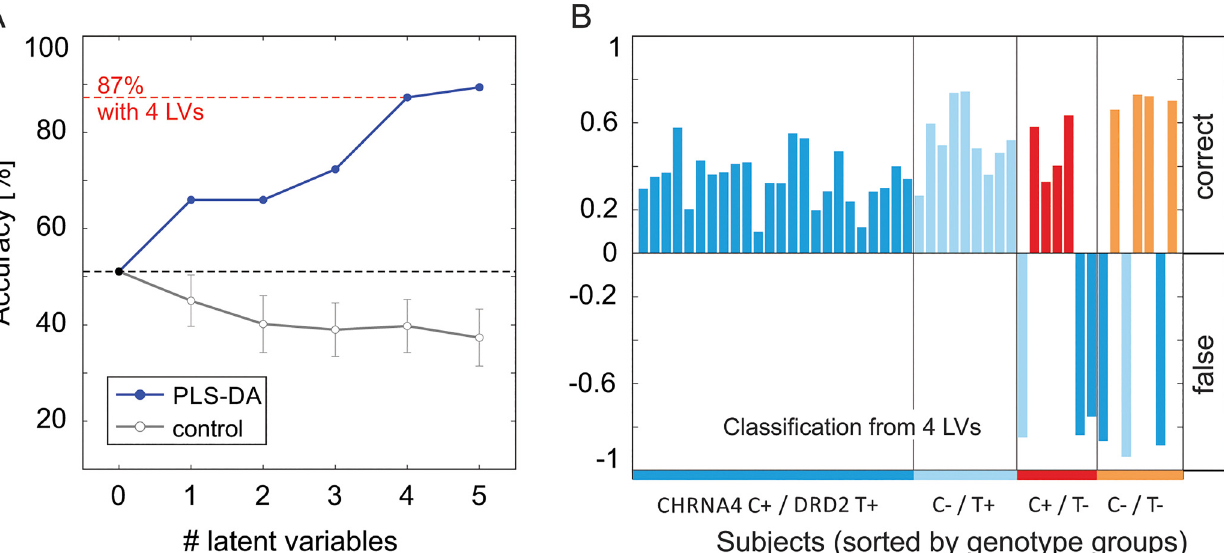
Fig 4. A. Classification accuracy. Prediction accuracy successively increases with adding LVs (blue). With four LVs, 41 out of 47 subjects (87.23%) were successfully assigned to their genetic group. When using no LV, all subjects were assigned to the genetic group with the highest frequency, which is the CHRNA4 C+ / DRD2 T+ group with n = 24 (51.06%). When randomizing the genotype groups among the subjects (control with SEM, repeated 50 times) the accuracy even drops below chance level which indicates that the PLS-DA models based on randomized groups only add noise to the prediction of the ‘ null ’ model. B. Uncertainty over subjects. Classification uncertainty over subjects based on the Euclidean distance between the predicted values and the dummy coded representation of the genotype group. Correct classifications are depicted as positive values, false classification as negative values. The grouping on the x-axis gives the true genotype groups of the subjects (together with the colour code). The bar colours give the assigned genotype group from the PLS-DA. Falsely classified subjects were present in the two smaller genotype groups (C+/T- and